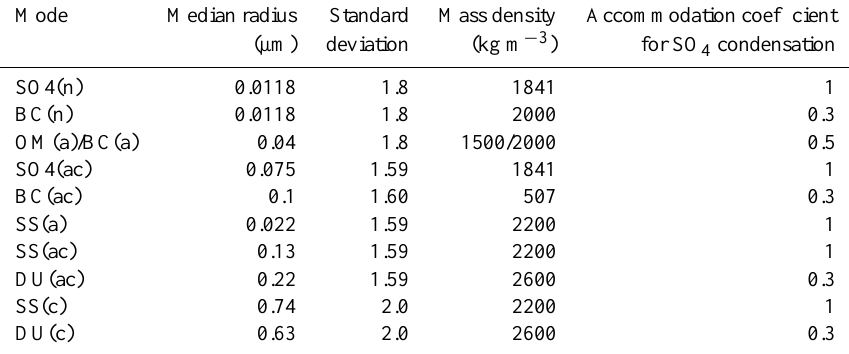
Table 1. Initial modal size parameters, mass densities and accommodation coefficients for primary emitted log-normal aerosol size modes. The aerosol compounds are explained in Fig. 1. BC(ac) is an externally mixed fractal agglomerate with particle radius dependent density, giving 507kgm − 3 averaged over all